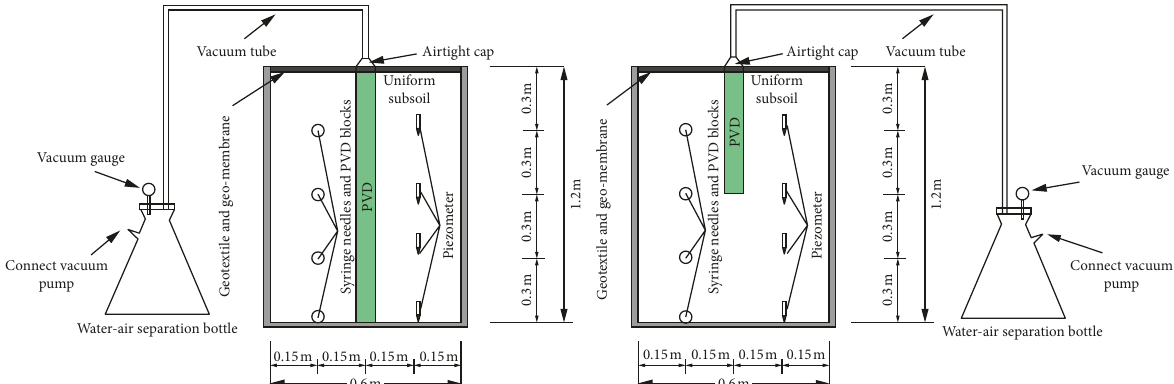
Figure 1: Model experiment conducted for improving the subsoil by embedding the PVDs with different lengths.